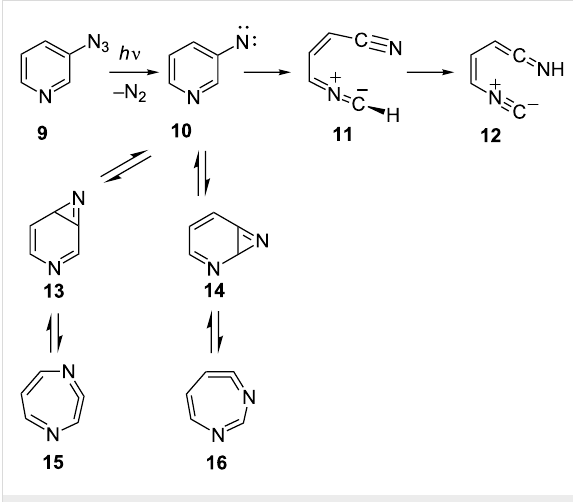
Scheme 3: Ring opening and ring expansion in 3-pyridylnitrene ( 10